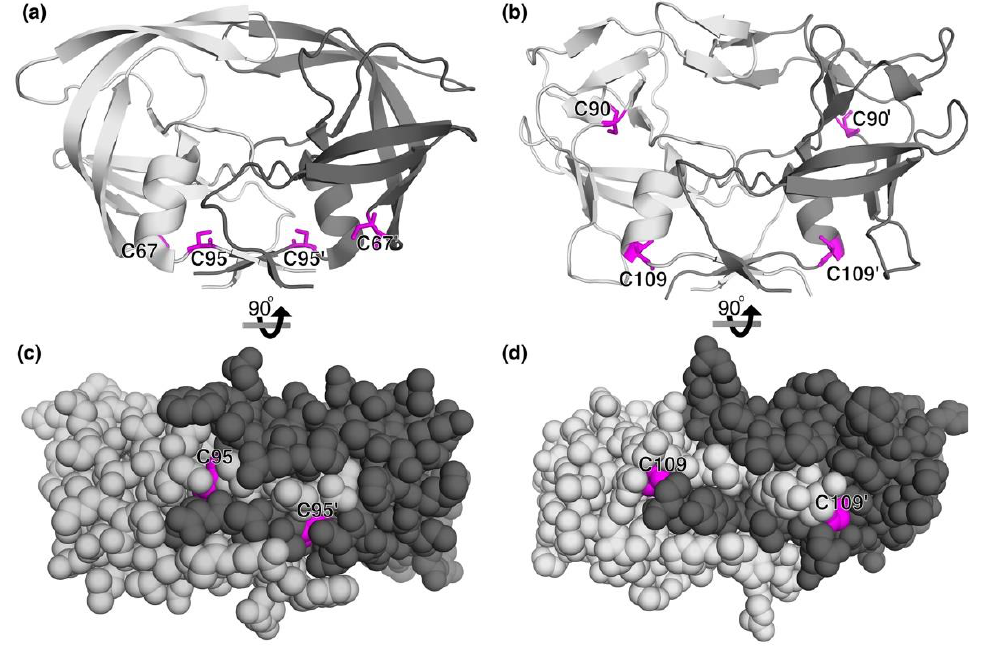
Figure 2. Side-by-side comparison of the ribbon and space filling models for HIV-1 ( a , c ) (PDB:4LL3) and HTLV-1 ( b , d )) (PDB:4YDF) proteases. The location of the two Cys residues in each protease is depicted in magenta in the ribbon drawings ( top ). The space filling models below each ribbon model are rotated 90 degrees to show the location of Cys95 (for HIV-1) and Cys109 (for HTLV-1) within the beta sheet interface regions (in magenta, bottom ).